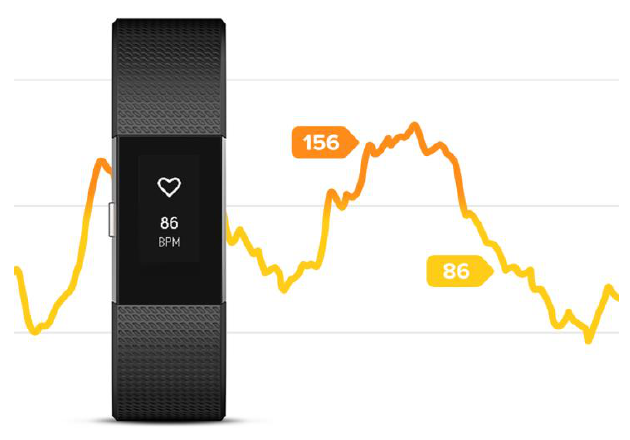
Figure 1. A popular wearable activity tracker displaying heart rate. (Various similar systems exist on the market [45], picture taken from